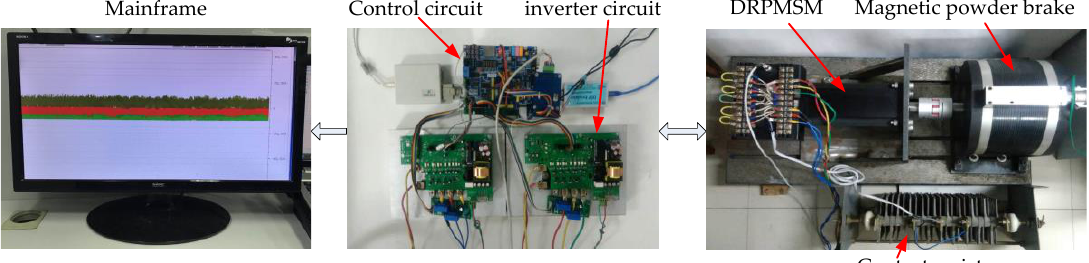
Figure 18. The experimental system diagram of the DRPMSM.